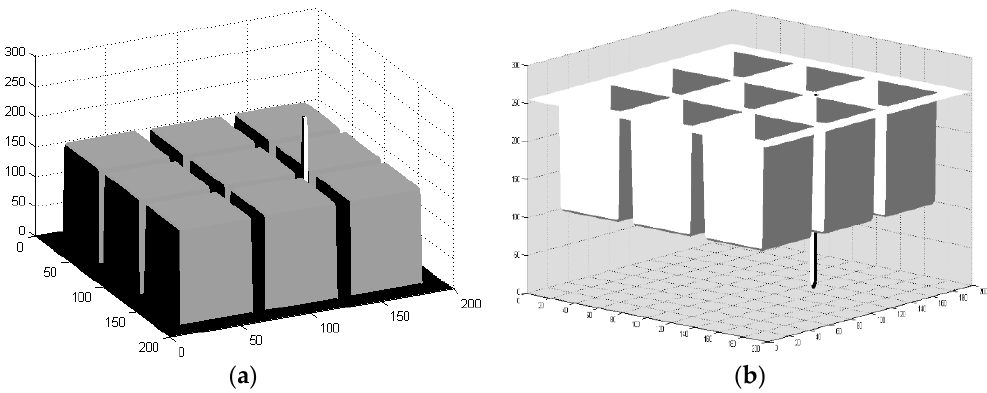
Figure 6. Data field with anomaly pixels. ( a ) v (cid:3029) = 0, v (cid:3042) = 150 ; ( b ) v (cid:3029) = 255, v (cid:3042) = 100 .